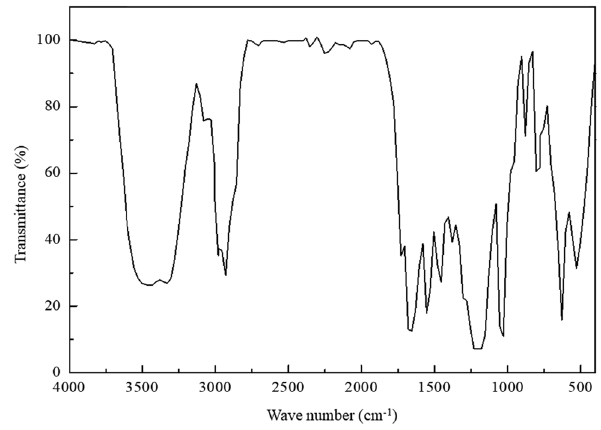
Figure 2: The FTIR image of RH - β - CD.